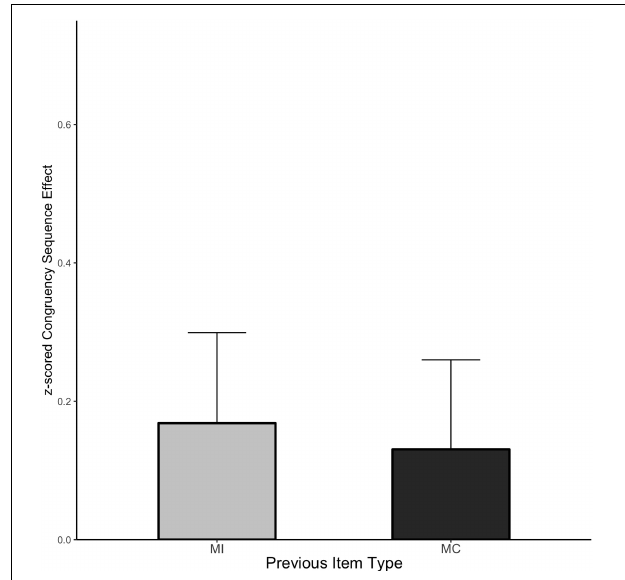
FIGURE 7 | CSE in Experiment 3. Error bars represent the 95% HDI.